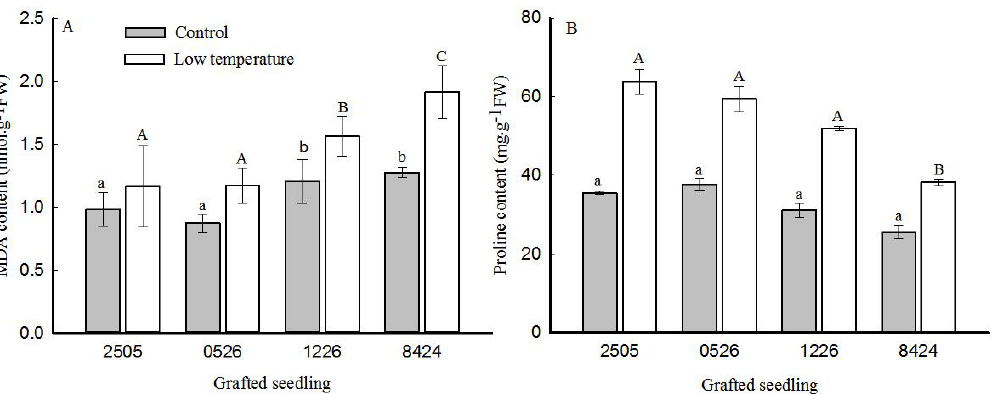
Figure 2. Effects of low temperature on MDA ( A ) and proline ( B ) content in leaves of different grafted seedlings. Data are the mean ± SE. Bars with different letters indicate a significant difference (p < 0.05).